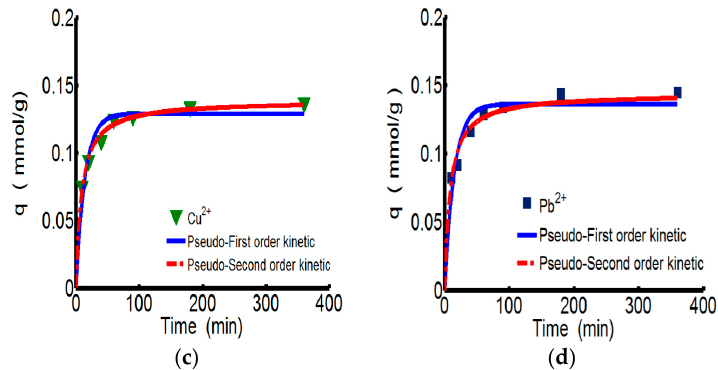
Figure 3. The kinetics curves of ChW and PTW. ( a ) ChW-Cu 2+ ; ( b ) ChW-Pb 2+ ; ( c ) PTW-Cu 2+ ; and ( d ) PTW-Pb 2+ .